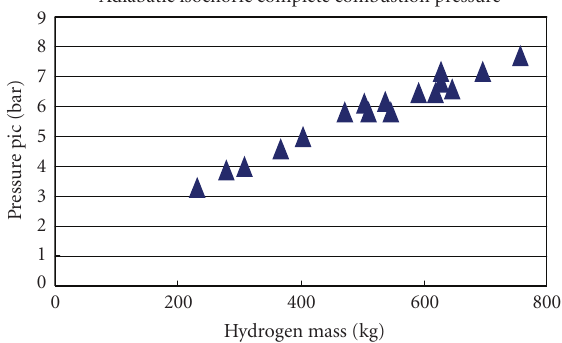
Figure 8: PAICC pressure versus hydrogen mass.